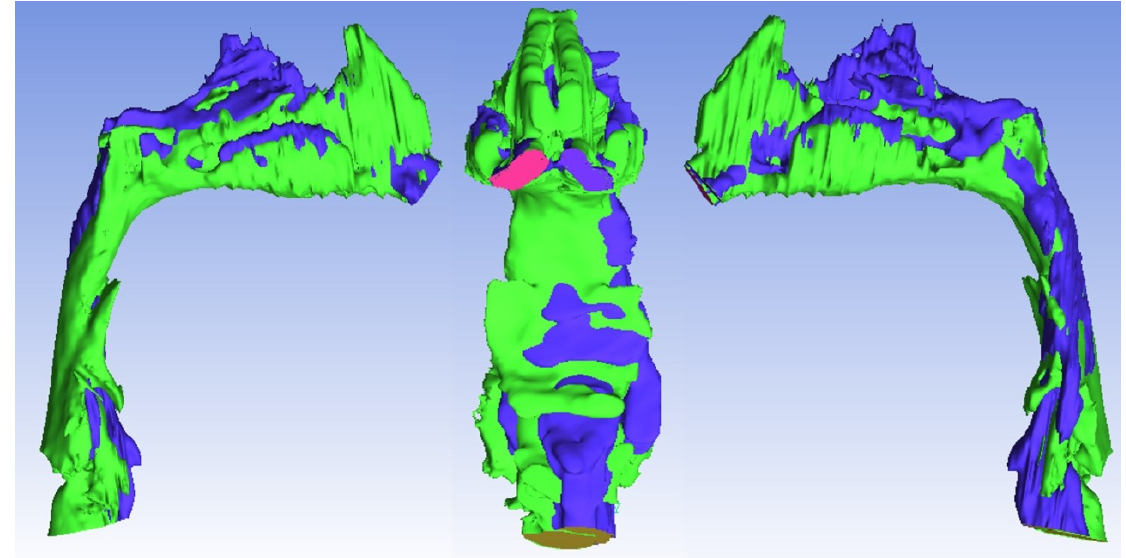
Figure 6. Superimposition of the pre- and post-pharyngeal airway model.